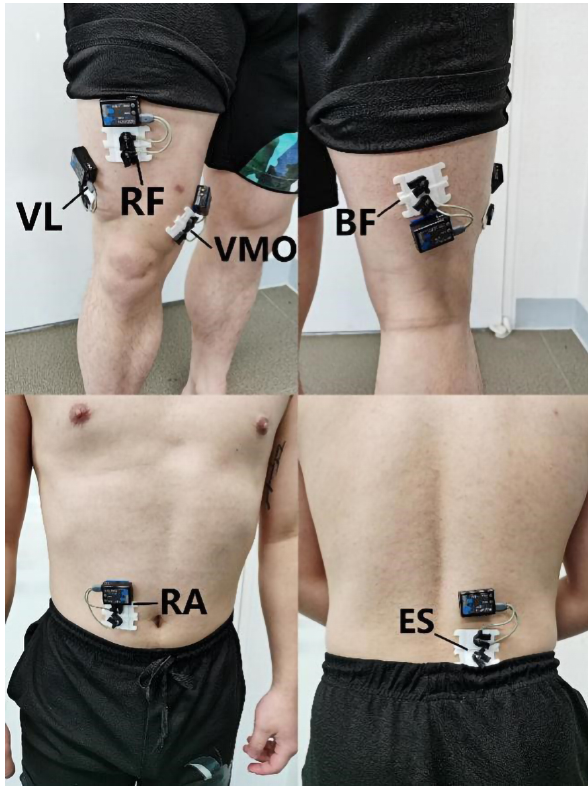
Fig. 3. The placement of surface electrode. VMO, vastus medi- alis obliques; VL, vastus lateralis; RF, rectus femoris; BF, biceps femoris; RA, rectus abdominis; ES, erector